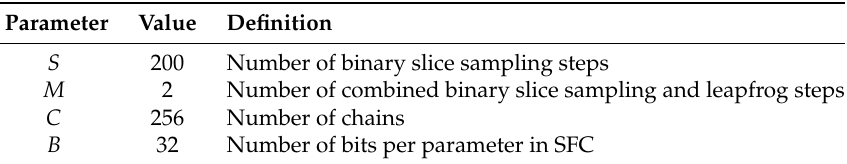
Table 3. Parameters for TI-BSS examples.